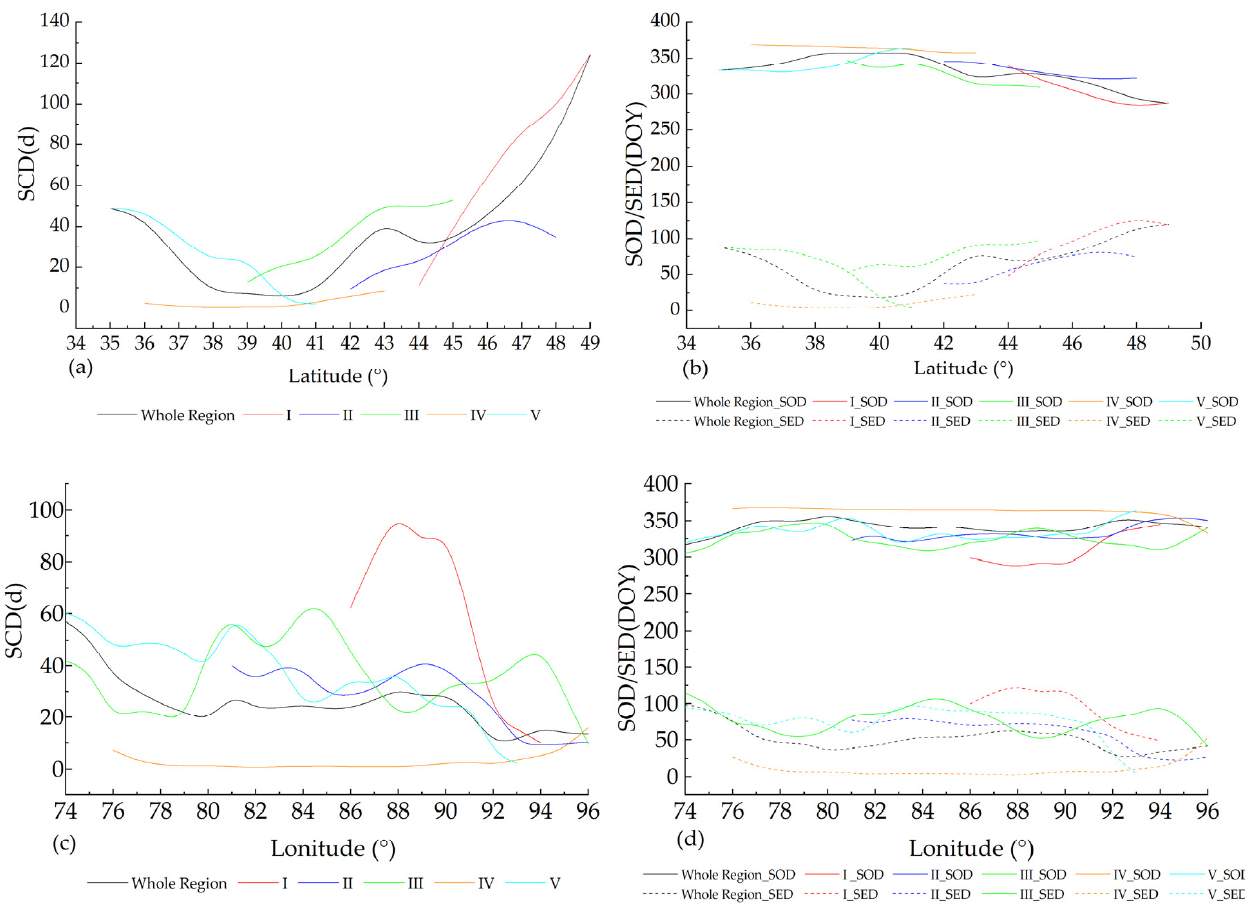
Figure 7. Variations of snow cover phenology with latitude and longitude: SCD ( a ) and SOD/SED